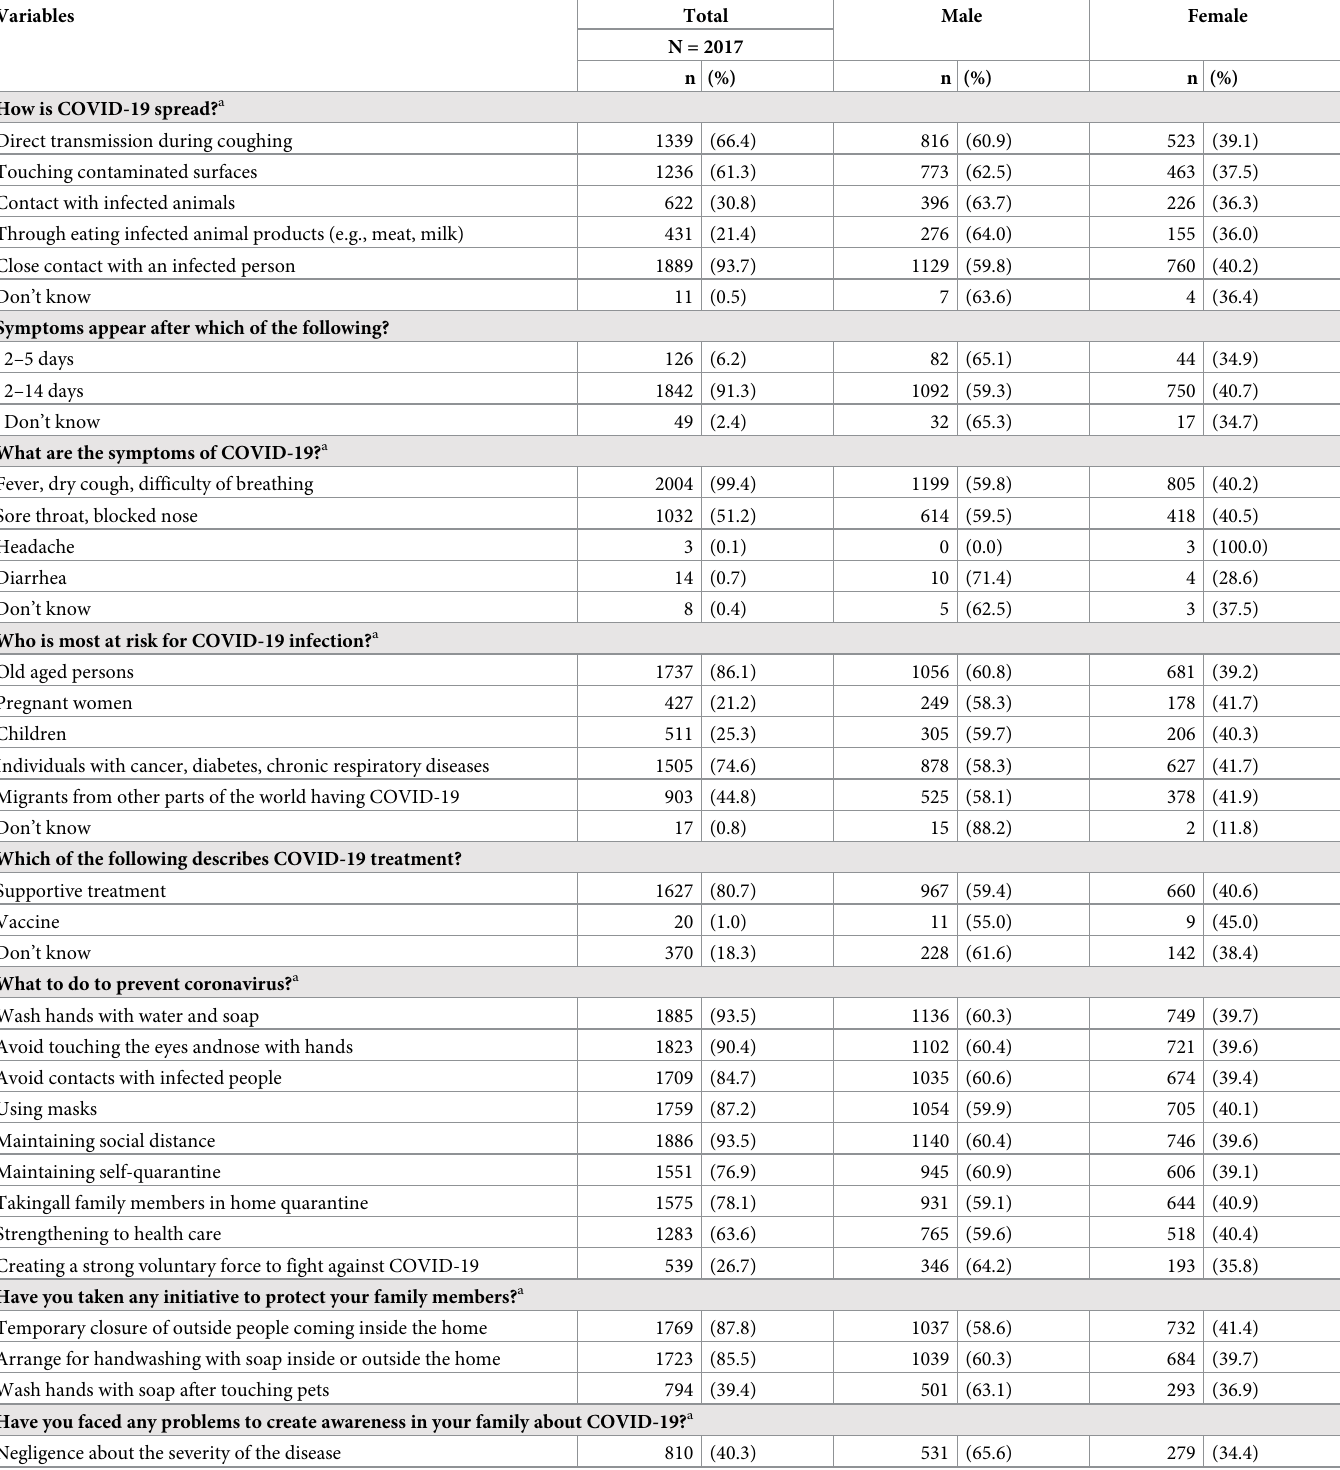
Table 2. Perception towards COVID-19 about the mode of transmission, incubation period, symptoms, risk factors, treatments, prevention initiatives, and